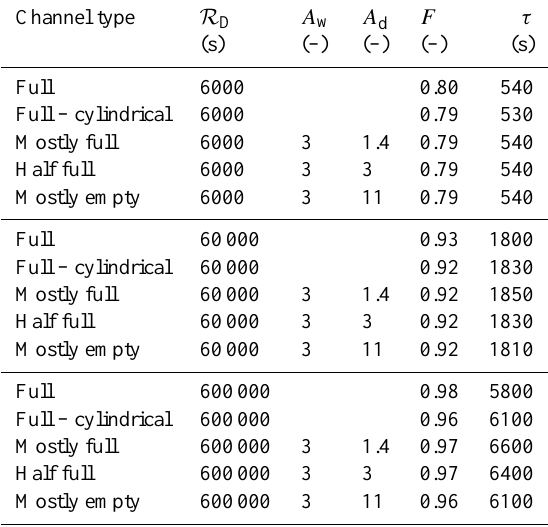
Table 5. Thermal transmission factors and retardation values of dif- ferent recharge shape